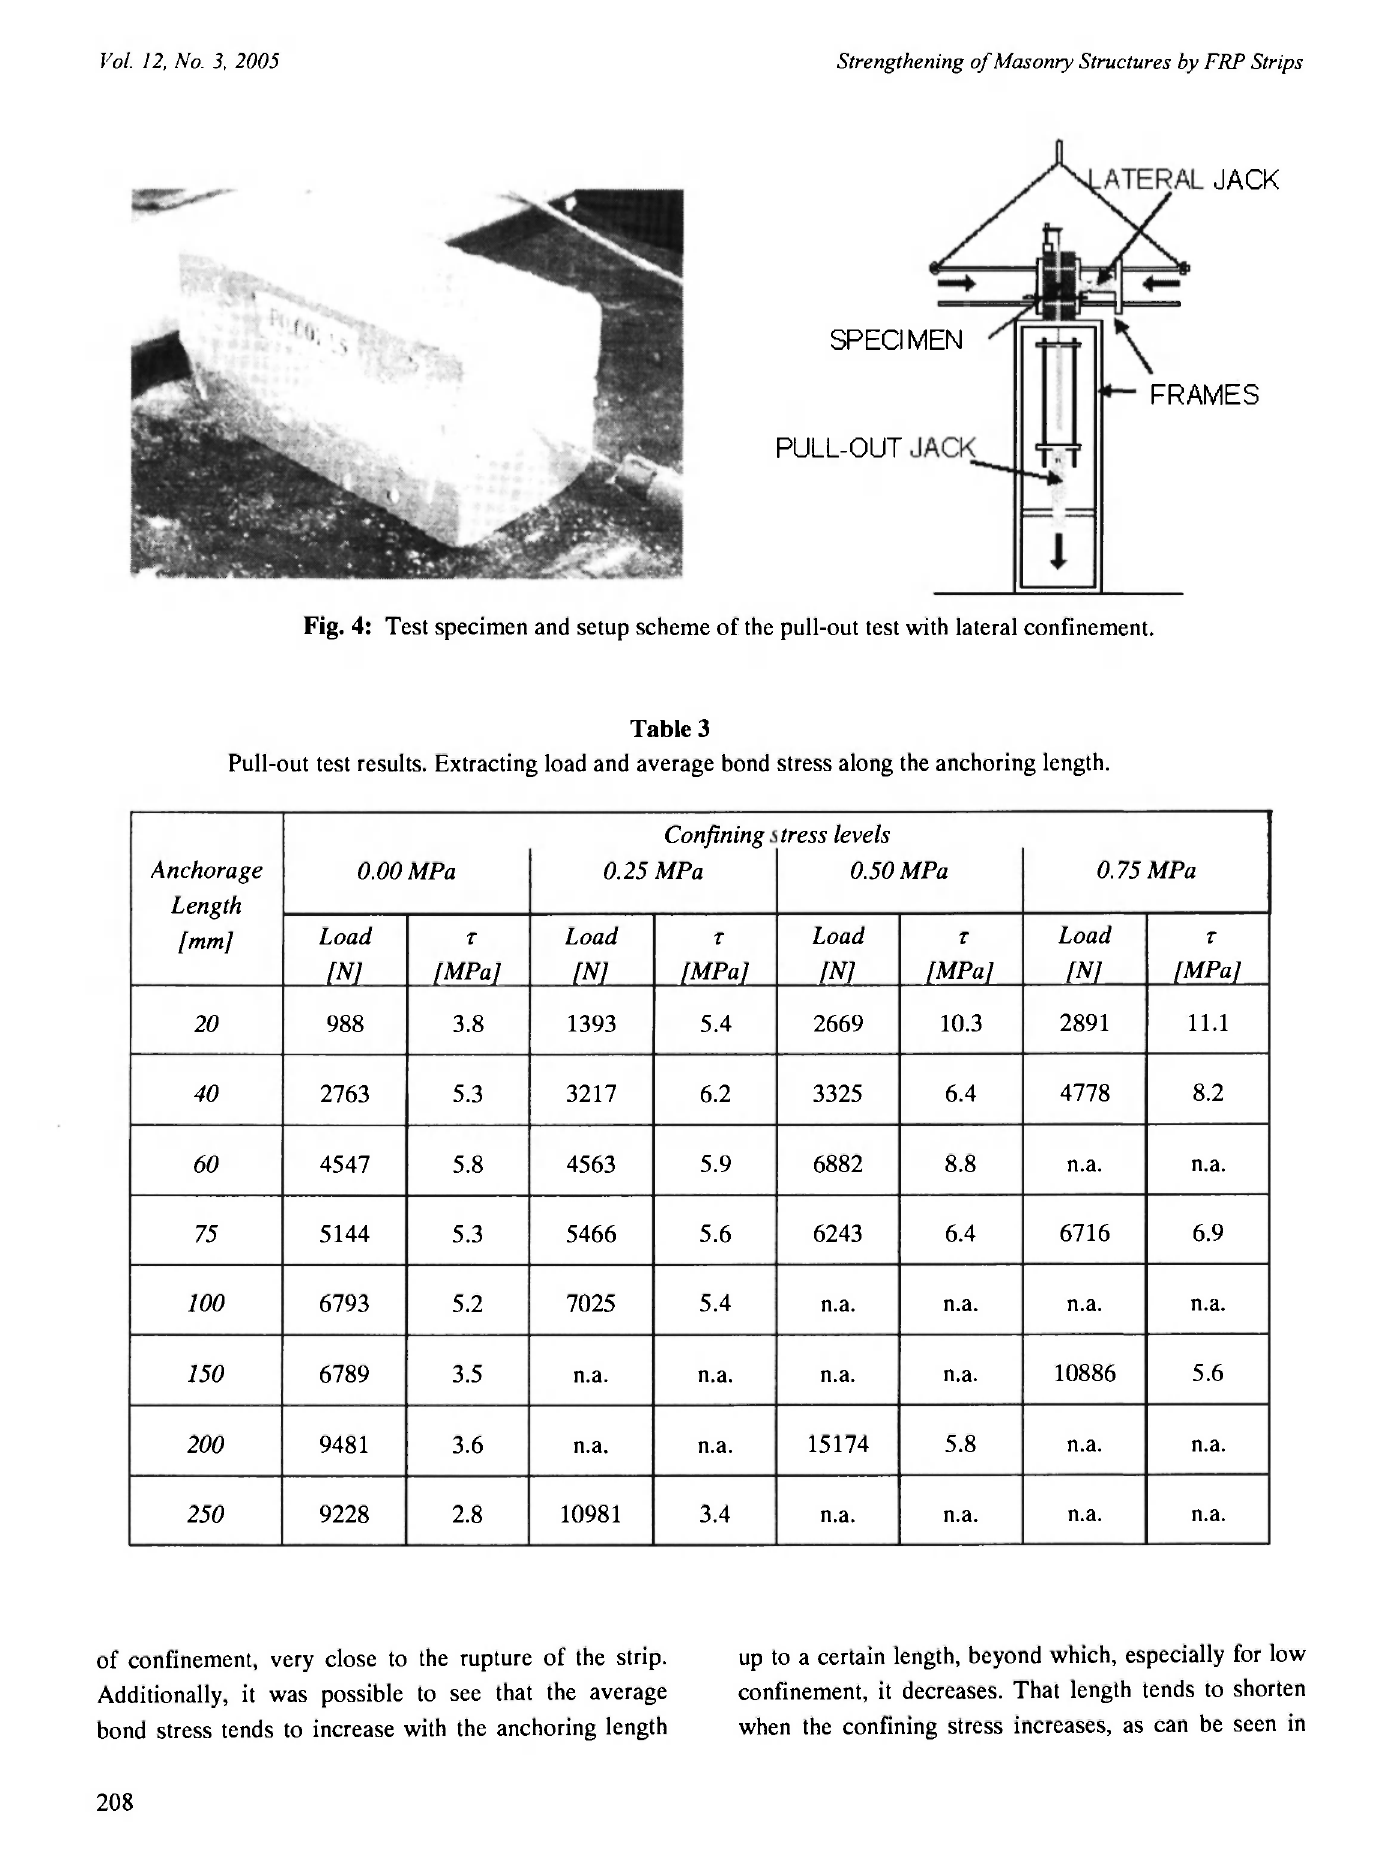
Fig. 4: Test specimen and setup scheme of the pull-out test with lateral confinement.